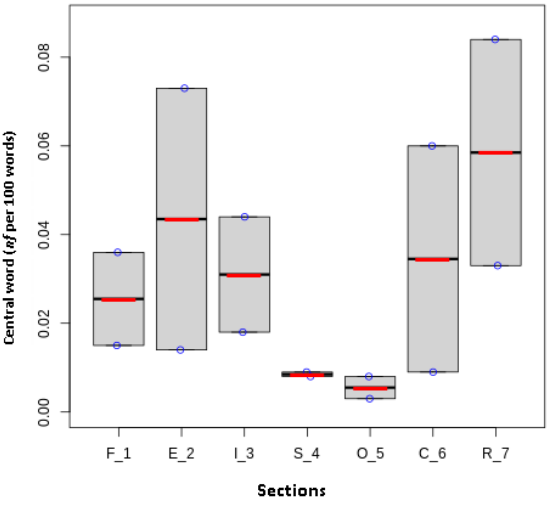
Figure 1. The adjusted frequencies nf ( rf × 100) for the different sections. Table 8. Dispersion analysis of the central word among the sections for the year 2021.